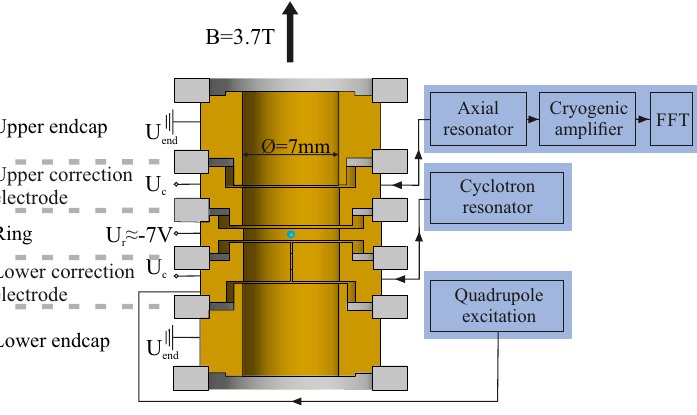
Figure 1. Five-electrode cylindrical Penning-trap with attached electronics for ion detection and